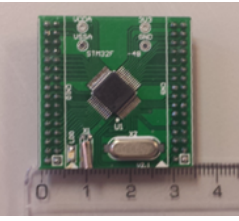
Figure 17. Reduced RCP system to miniaturize the size of the electronics. The units are